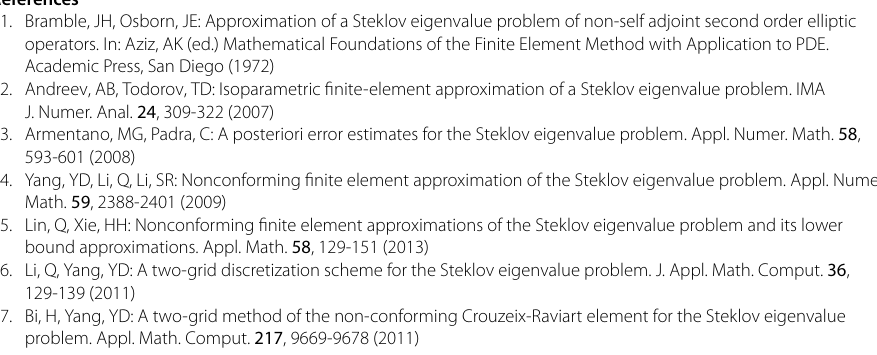
Table 2 The approximative eigenvalues on N DOF χ 1 χ 2 χ 5 10